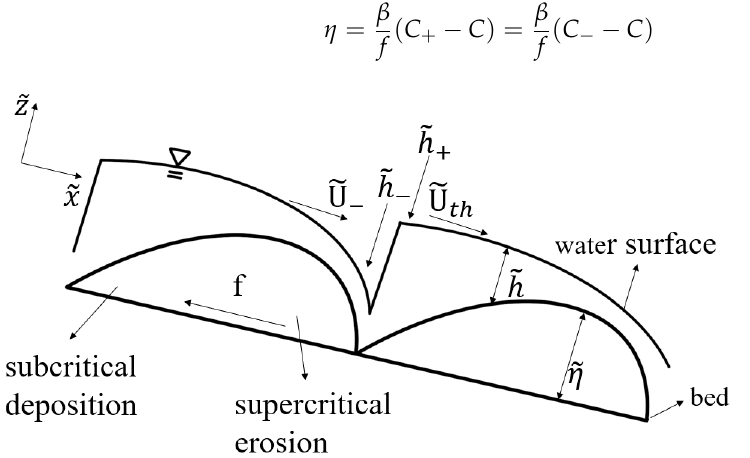
Figure 2. Conceptual sketch of cyclic